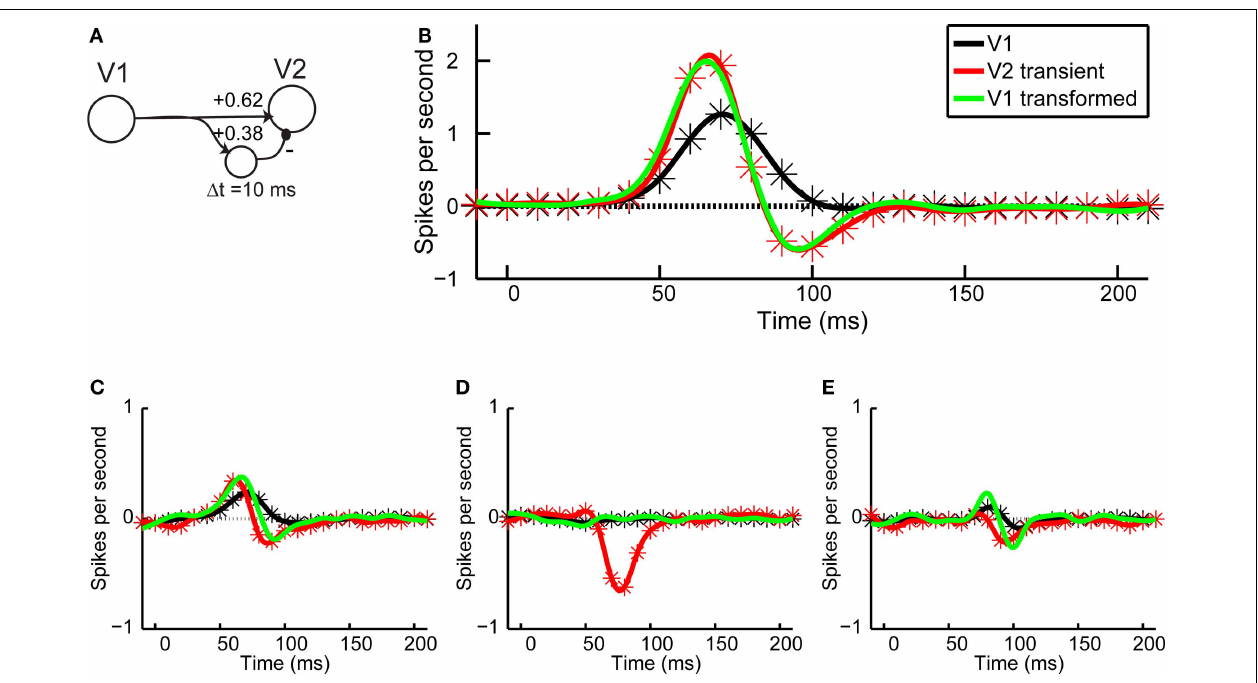
panel (A) . (C) Average second-order responses across boundaries orthogonal to the preferred orientation for V1 (black) and transient V2 (red), and the transformed V1 signal (green). (D) Same as in (C) , but for second-order responses across boundaries parallel to the preferred direction. (E) Same as in (C) , but for temporal second-order